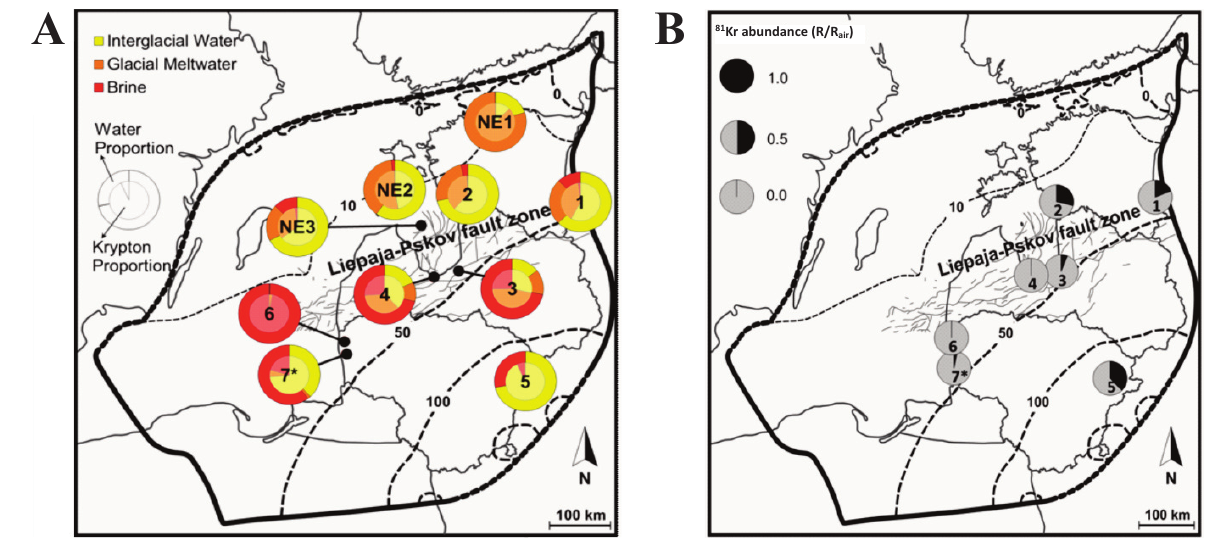
Fig. 3. A , spatial distribution of the proportions of the three end-members in the deep groundwater of the Cambrian aquifer system (CAS) and the corresponding proportions of Kr. Present-day hydraulic heads (dashed lines, in metres above sea level) in the CAS are according to Virbulis et al. (2013). Also shown are results for selected samples from northern Estonia (NE1–NE3, data from Raidla et al. 2009). B , the spatial pattern of contamination-corrected 81 Kr abundances. Dashed black lines are isobars of the present- day piezometric head (m a.s l.) in the Cambrian–Vendian aquifer system (CVAS) modelled by Virbulis et al. (2013). From Gerber et al.